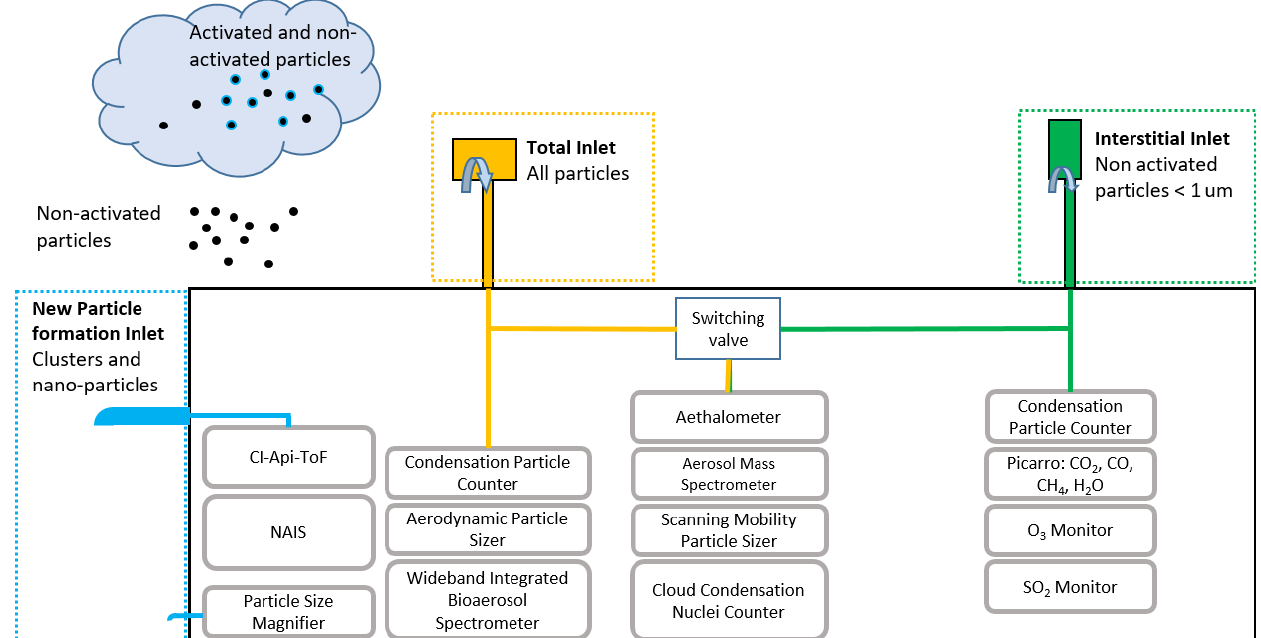
Figure A3. Full setup of the Swiss Container during the MOSAiC expedition (not all elements are discussed in this paper). In yellow the total inlet, in green the interstitial inlet. The valve switched between the two inlets to allow the instruments behind it (Aethalometer, AMS, SMPS, cloud condensation nuclei counter) to measure from both inlets. The blue inlet is the new particle formation inlet. CI-Api-ToF stands for chemical ionization atmospheric pressure interface time-of-flight mass spectrometer. NAIS stands for neutral cluster and air ion spectrometer.